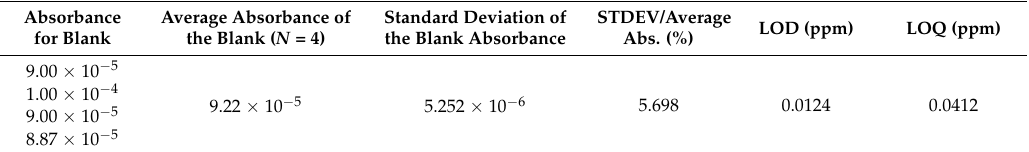
Table 4. The reported statistical